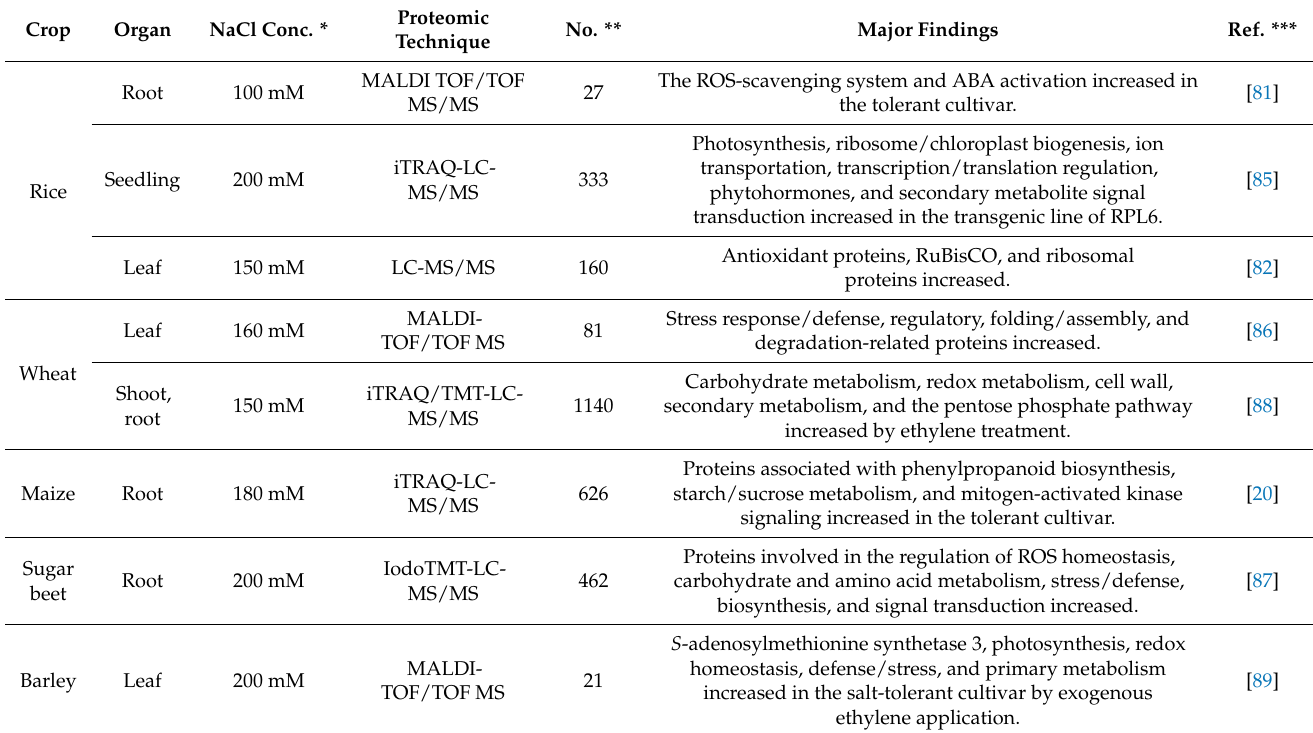
Table 3. Proteomic techniques used for the improvement of salt stress tolerance in crops studied during